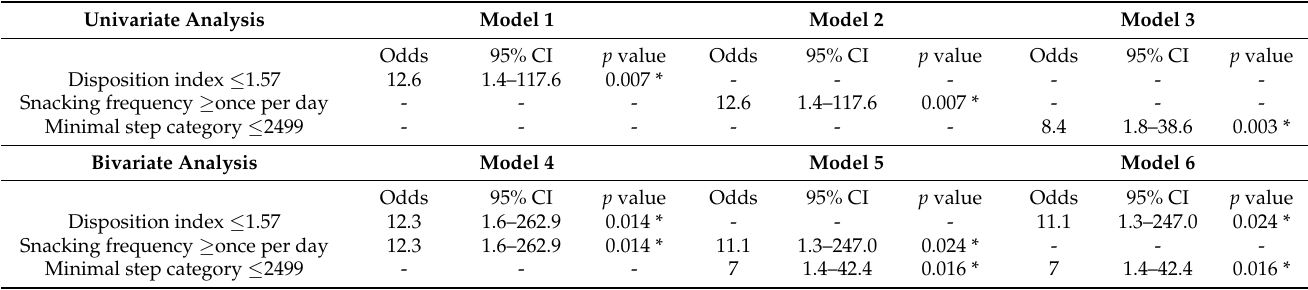
Table 4. Associations between the categories of disposition index, snacking frequency, or minimal steps and the risk of having the maximal CGM glucose level ≥ 200